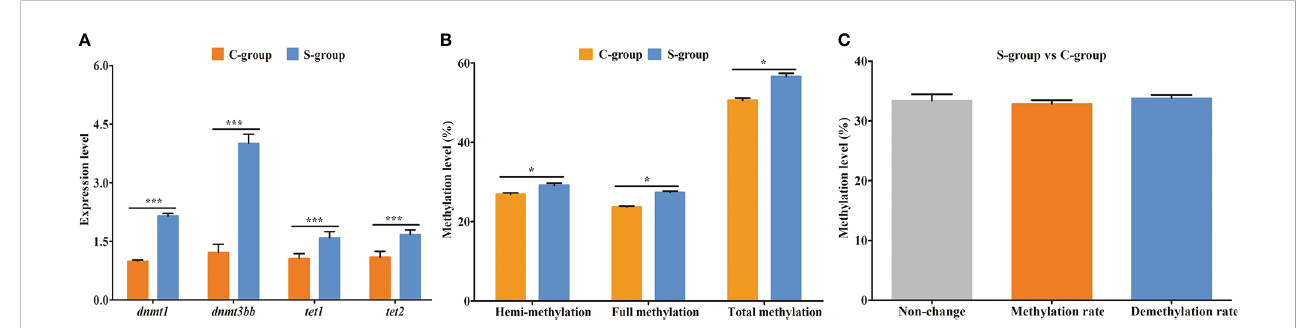
FIGURE 1 Expression of methyltransferase genes and genomic DNA methylation status in gills of large yellow croaker under low-salinity stress. (A) relative expression of DNA transmethylase genes ( dnmt1 and dnmt3bb ) and demethyltransferase genes ( tet1 and tet2 ); (B) methylation level of gill in the S-group and C-group; (C) genomic DNA CpG site methylation status. *, represent the difference is signi fi cant ( p <0.05); ***, represent the difference is extremely signi fi cant ( p